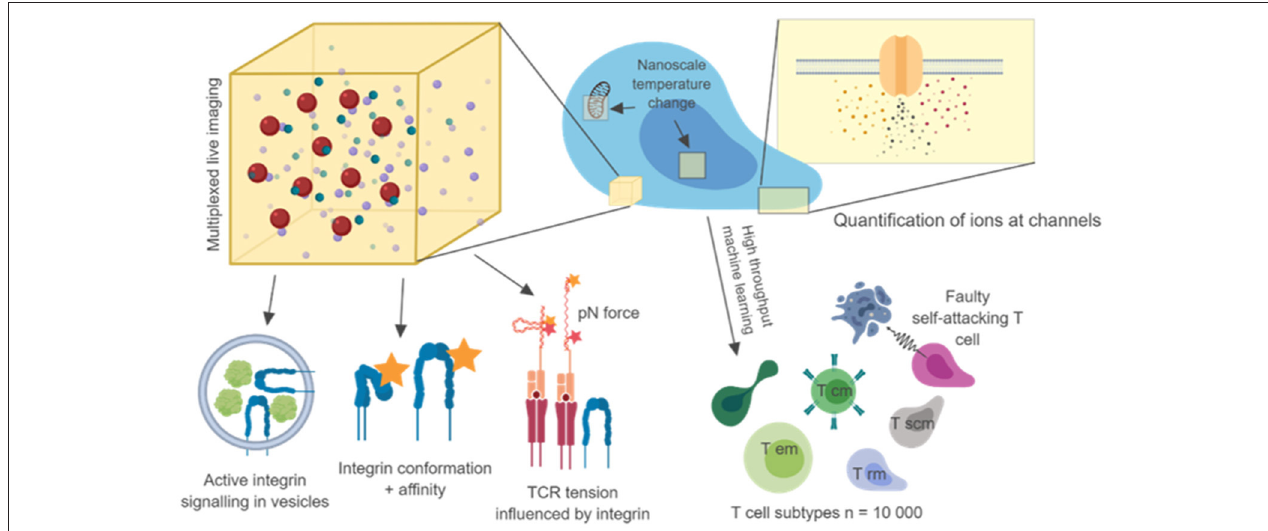
FIGURE 1 | Nanoscale imaging with multiple metrics and high throughput microscopy. Nanoscale readouts, combined with high throughput analysis may link single cell, multi cell and in vivo behavior to separate T cell subtypes and disease phenotypes. Combining 3D nanoscale live-cell imaging of many targets with other nanoscale measures such as tension, temperature, conformation will help us to make causal links to single cell behavior. The use of machine learning and automation to image 1,000s of cells and billions of molecules will help us to create true trans-scale experiments. Diagram created using